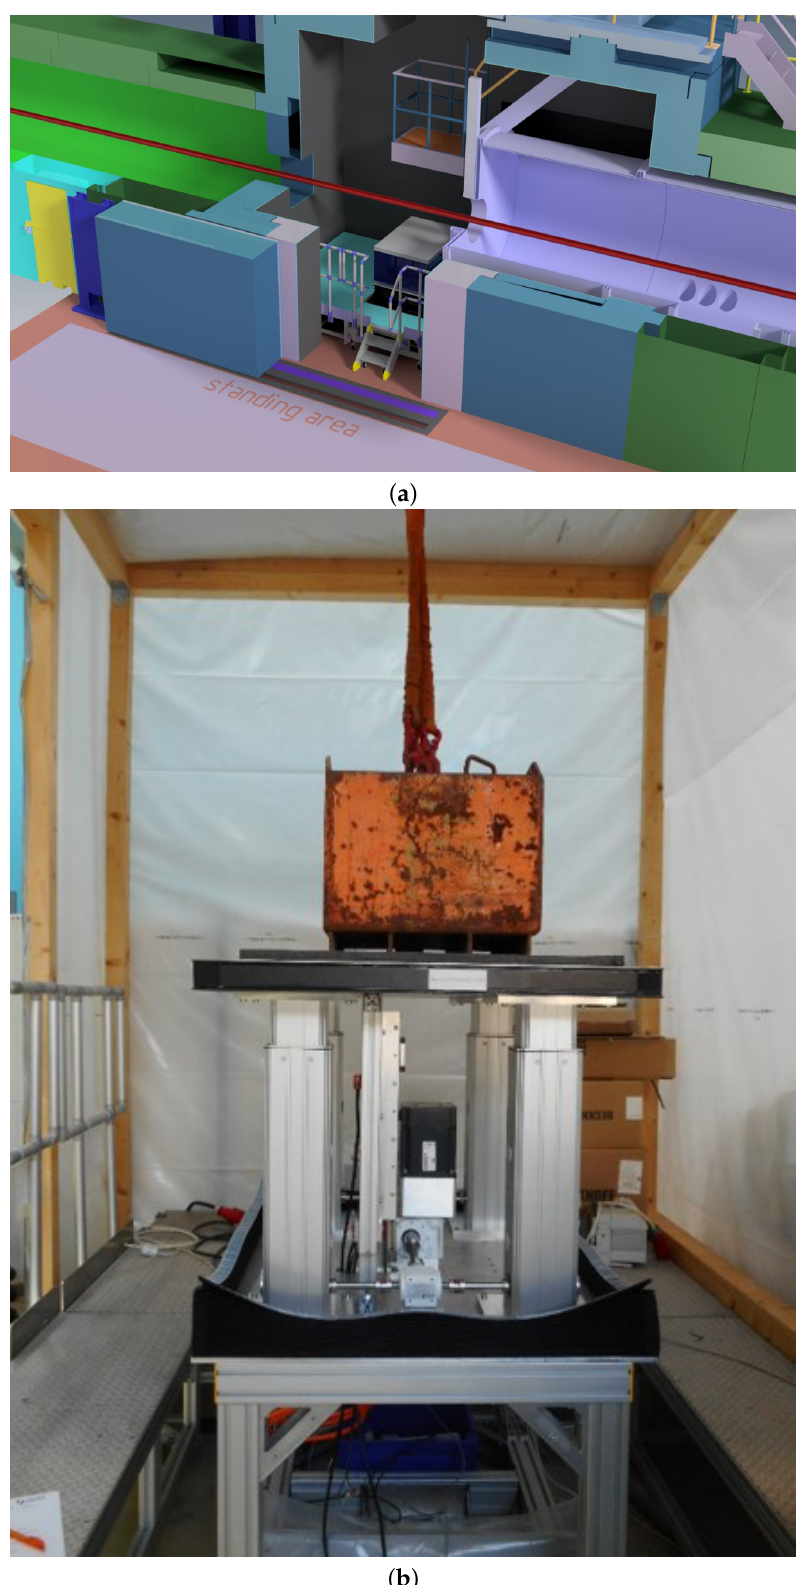
Figure 8. ( a ) CAD cut of the sample area, neutron beam is indicated in red. ( b ) Photograph of the sample stage and false floor in a mockup of the sample area, as seen from the detector tube. Test load on table is 732 kg, not affecting the positioning accuracy of 0.1